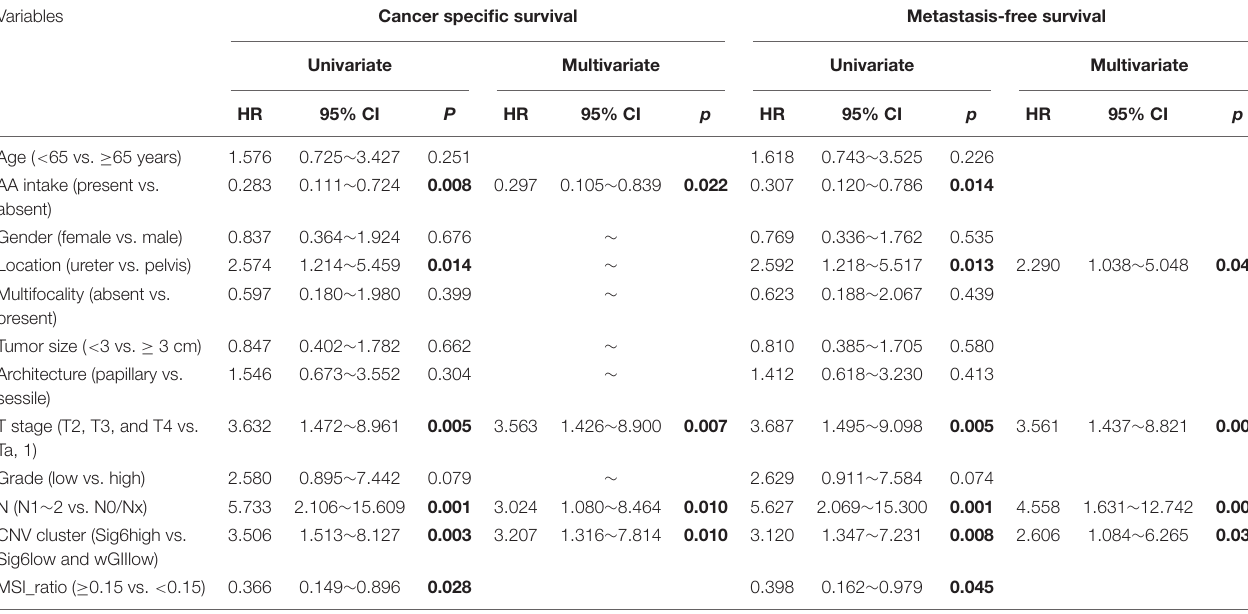
TABLE 2 | Univariate and multivariate Cox regression analyses predicting cancer-specific survival and metastasis-free survival. Variables